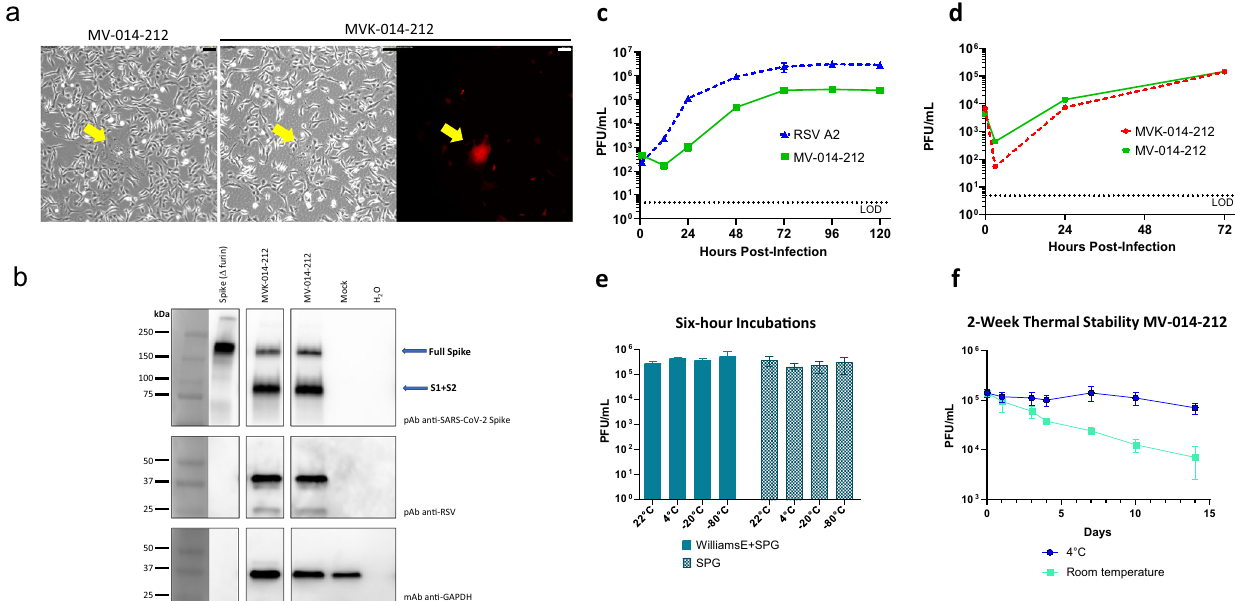
Fig. 2 In vitro characterization of MV-014-212. a Syncytia formed by MV-014-212 and MVK-014-212. Micrographs were taken at a total ampli fi cation of 100× under phase contrast or using tetramethylrhodamine fi lter. Yellow arrows point to syncytia. Scale bars are 100 µm. b Western blot showing full-length puri fi ed SARS-CoV-2 spike protein lacking the furin cleavage site (lane 1), MVK-014-212 (lane 2), MV-014- 212 (lane 3), mock-infected Vero cell lysate (lane 4), blank (lane 5). The molecular weight markers correspond to the migration of the BIO-RAD Precision Plus Protein Dual Color Standards. The blue arrows indicate the expected size of the full-length spike and the cleaved protein (S1 + S2). The blots were derived from the same experiment and processed in parallel. c Multicycle replication kinetics of MV-014-212 compared to respiratory syncytial virus (RSV) A2 in serum-free Vero cells. Cells were infected at an MOI of 0.01 and incubated at 32 °C. Cells and supernatants were collected at 0, 12, 24, 48, 72, 96, and 120 h post infection. Titers of the samples were determined by plaque assay in Vero cells. Data points represent the means of two replicate wells and error bars represent the standard deviation. d Multicycle replication kinetics of MV-014-212 compared with MVK-014-212 in serum-free Vero cells. Cells were infected at an MOI of 0.01 and incubated at 32 °C. Cells and supernatants were collected at 0, 3, 24, and 72 h post infection. Titers of the samples were determined by plaque assay in Vero cells. Data points represent the means of three replicate wells and error bars represent the standard deviation. e Short-term thermal stability assay. Virus stocks of MV-014-212 prepared in Williams E medium supplemented with sucrose phosphate glutamate (SPG) buffer or prepared in SPG alone were incubated for 6 h at − 80 °C, − 20 °C, 4 °C, and room temperature and the titer determined by plaque assay. The bars show the mean of 2 technical replicates of 3 different samples, and the error bars denote SD. f Two-week thermal stability assay. Virus stocks of MV-014- 212 in Williams E medium supplemented with SPG buffer were incubated for 14 days at 4 °C and room temperature (18 °C to 22 °C ± 2 °C) and the titer determined by plaque assay. The bars show the mean of 2 technical replicates of 3 different samples, and the error bars denote